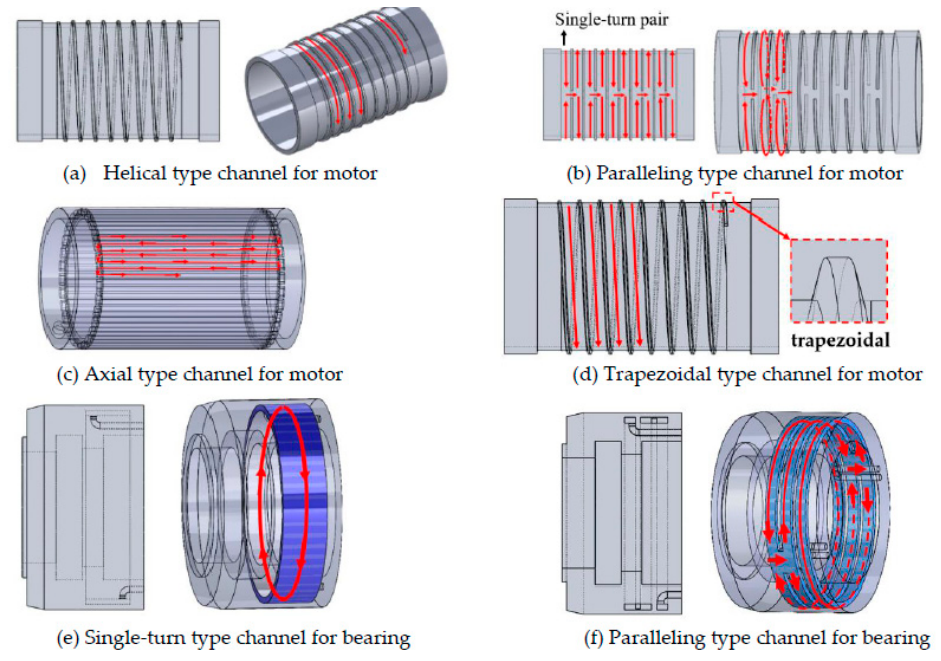
Figure 3. Appl. Sci. 2020 , 10 , x FOR PEER REVIEW